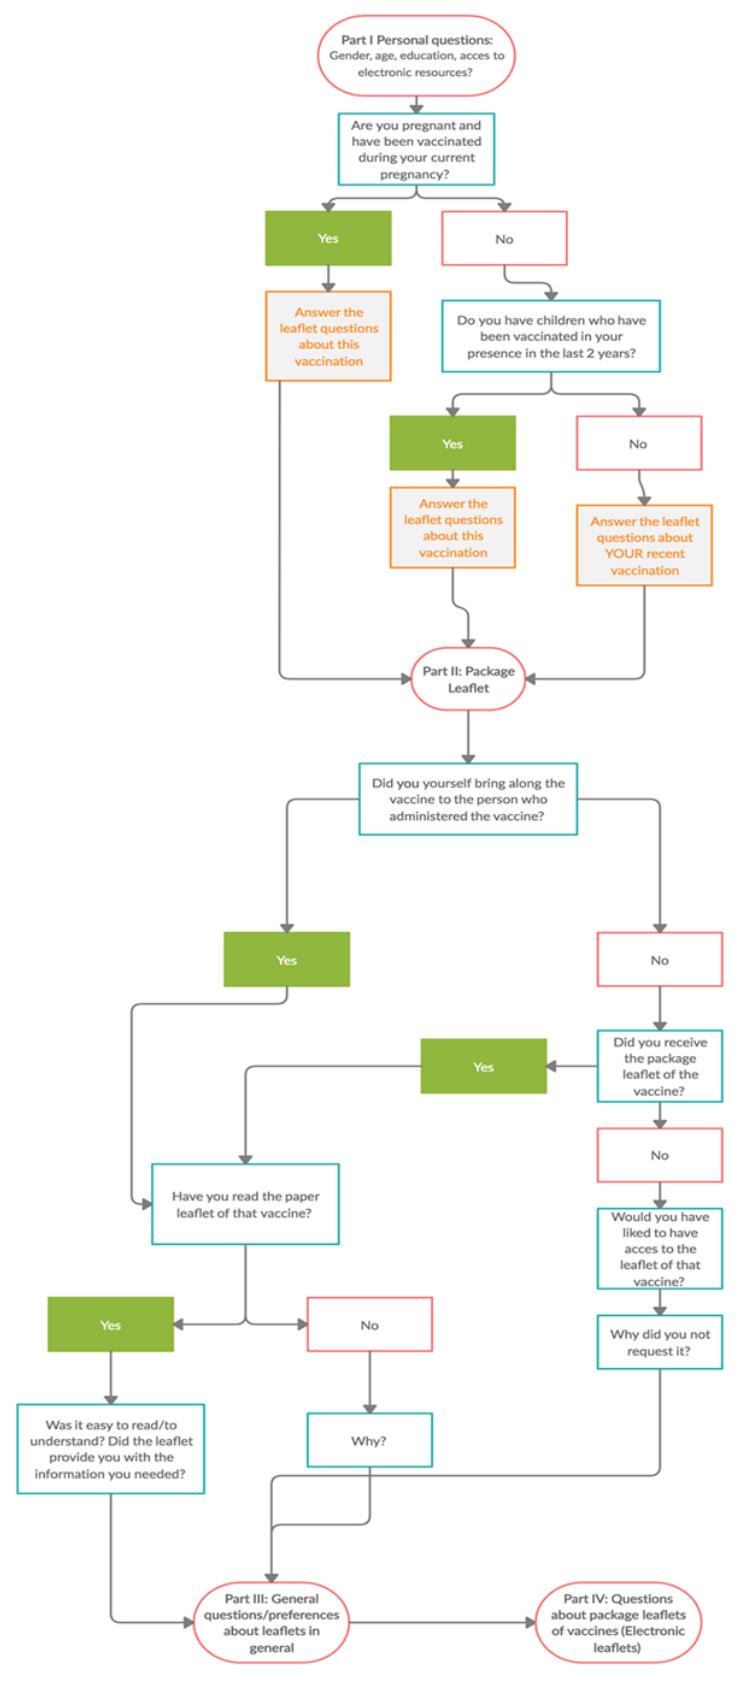
Figure 1. Flow chart of the questionnaire.